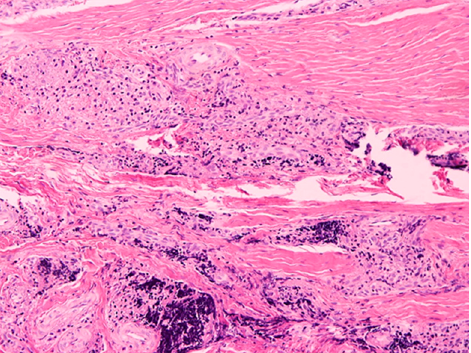
Figure 5. Cyst wall with massive chronic inflammatory infiltrate. H + E staining.